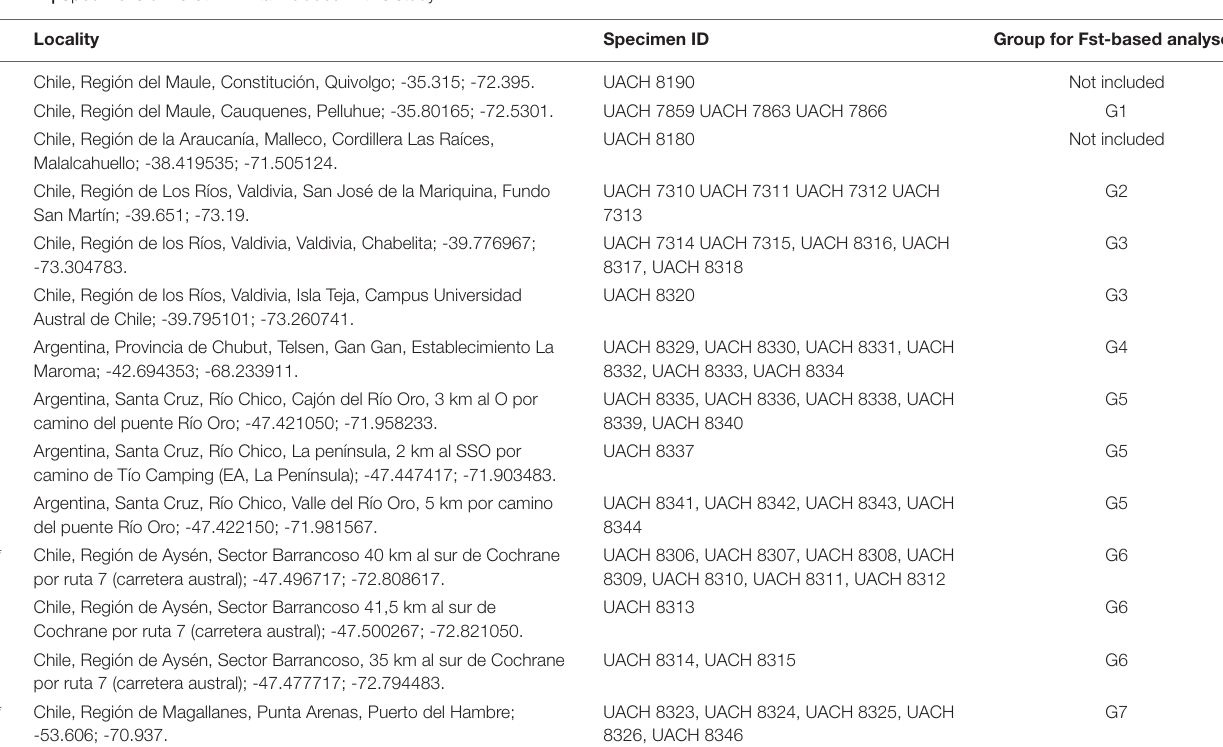
TABLE 1 | Specimens of Abrothrix hirta included in this study.